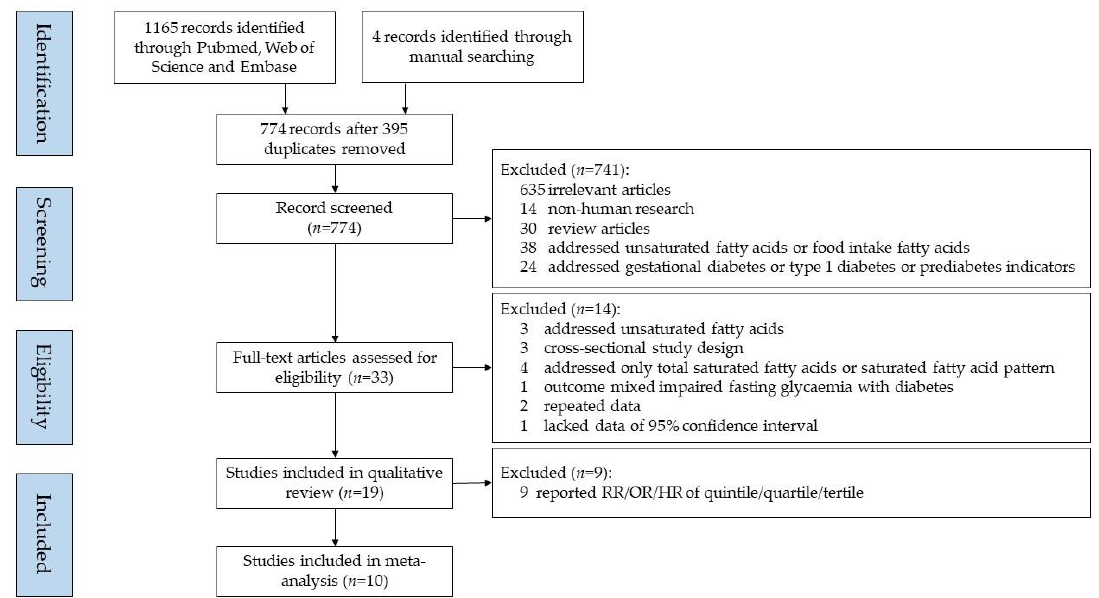
Figure 1. Flow diagram of the study selection.